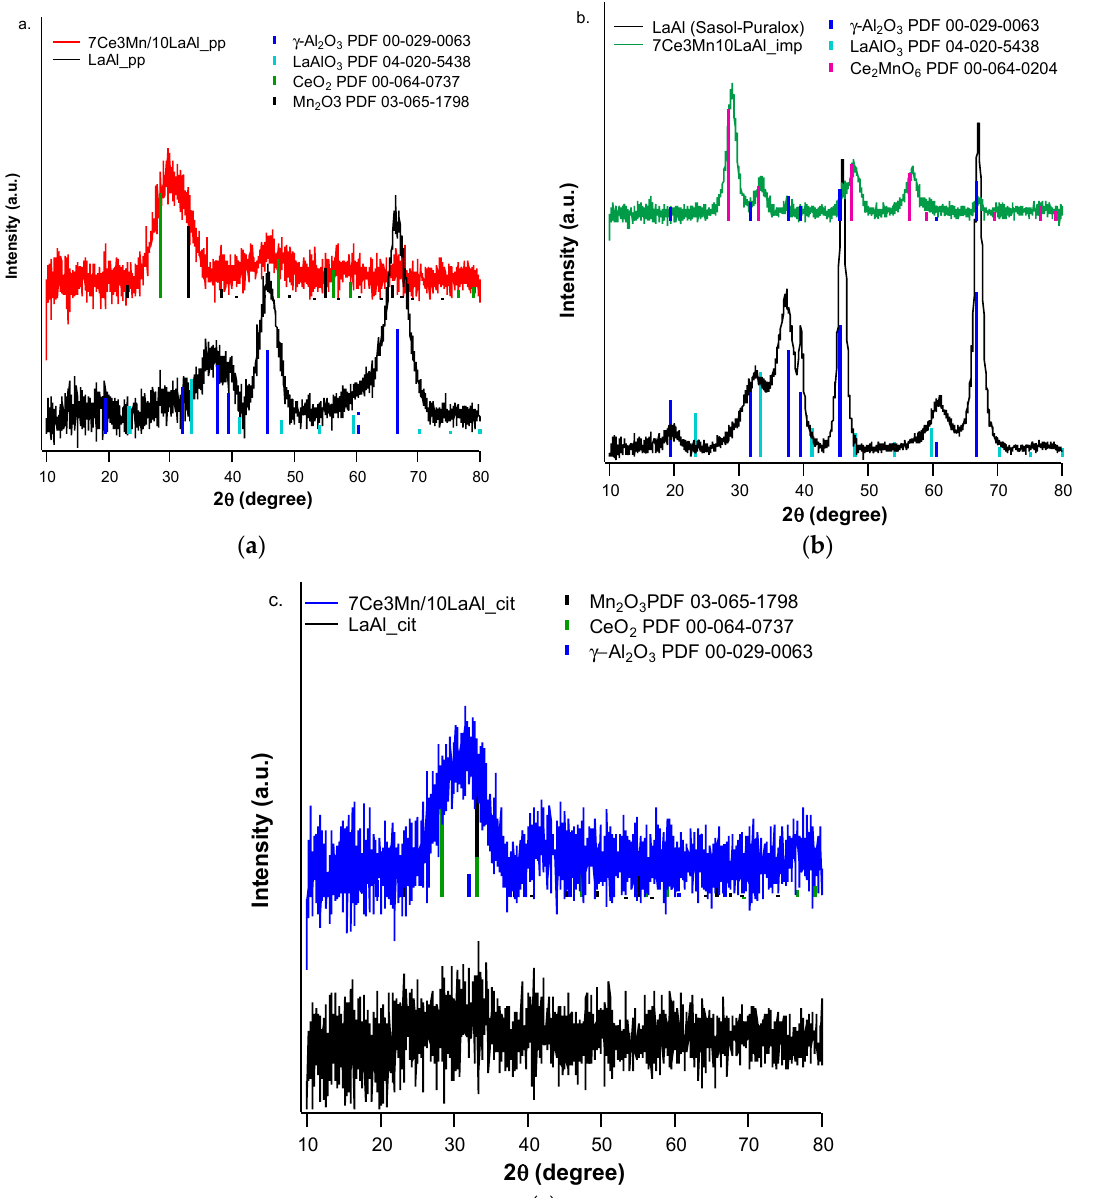
Figure 4. The X-ray diffraction (XRD) patterns of all CeMn/LaAl materials prepared: ( a ) coprecipitation method; ( b ) incipient impregnation of commercially available Sasol Puralox TH100 4 wt.% La 2 O 3 –Al 2 O 3 and ( c ) citrate-based sol-gel method.